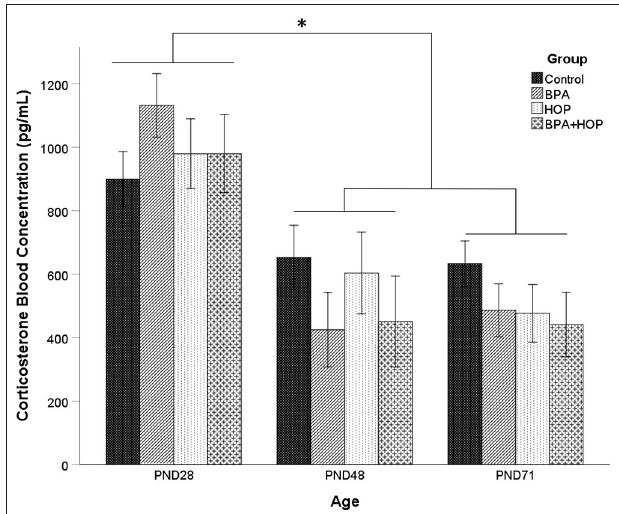
FIGURE 2 | Blood samples were collected on the first (PND 28) and last day (PND 48) of gavage, and on the last day of experiment (PND 71) between 8 and 10A.M. prior to gavage (Control: n = 8; BPA: n = 8; Hop: n = 6; BPA-Hop: n = 4). There was no significant effect of supplementation on corticosterone (CORT) levels, although a significant effect of time was found related to higher CORT levels in all the groups on PND 28 compared to the other collection intervals. Data are represented as mean ± SEM. * p < 0.05.